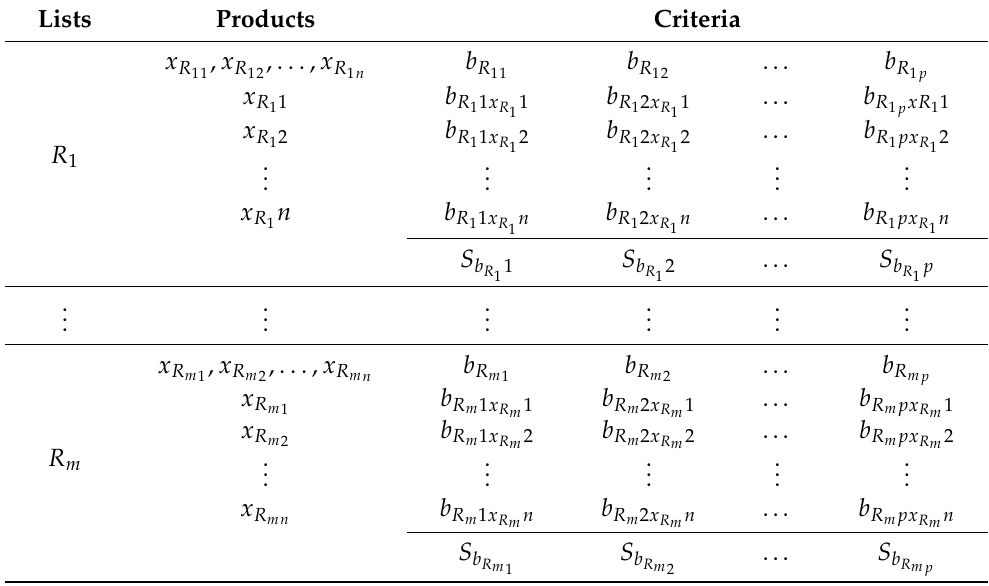
Table 18. Structure of the requested shopping list and solution alternatives/suggested shopping lists.